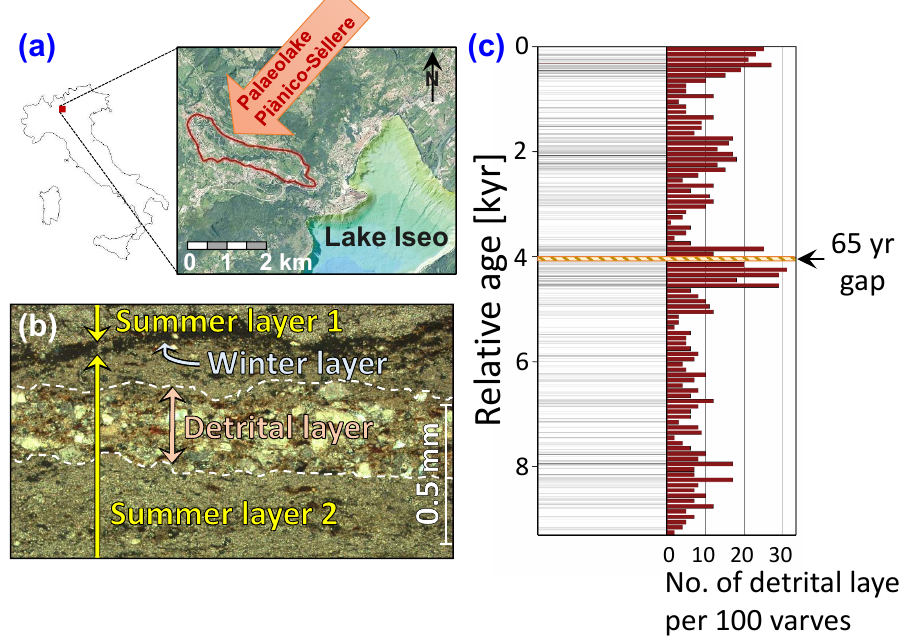
Figure 2. Site, sediment outcrop, and data. (a) Location of palaeolake Piànico–Sèllere, Italy. Underlying image © 2017 DigitalGlobe. (b) Detail of the 9.5m sediment outcrop containing a winter layer and parts of two summer layers with, shown here, a detrital layer that is interpreted as a flood event. (c) Graphical representation of the sediment outcrop with the grey horizontal lines indicating detrital layers, brown horizontal bars indicating the number of detrital layers per decade and the striped bar showing a 65-year gap (see Fig. 3 for more detailed time series). The relative age represents years before the top of the stratigraphic section examined, with actual age estimated to be anywhere from 780 to 393ka (see text). These data, the number of detrital layers per year, have been lodged online at the World Data Centre PANGEA (Mangili et al.,